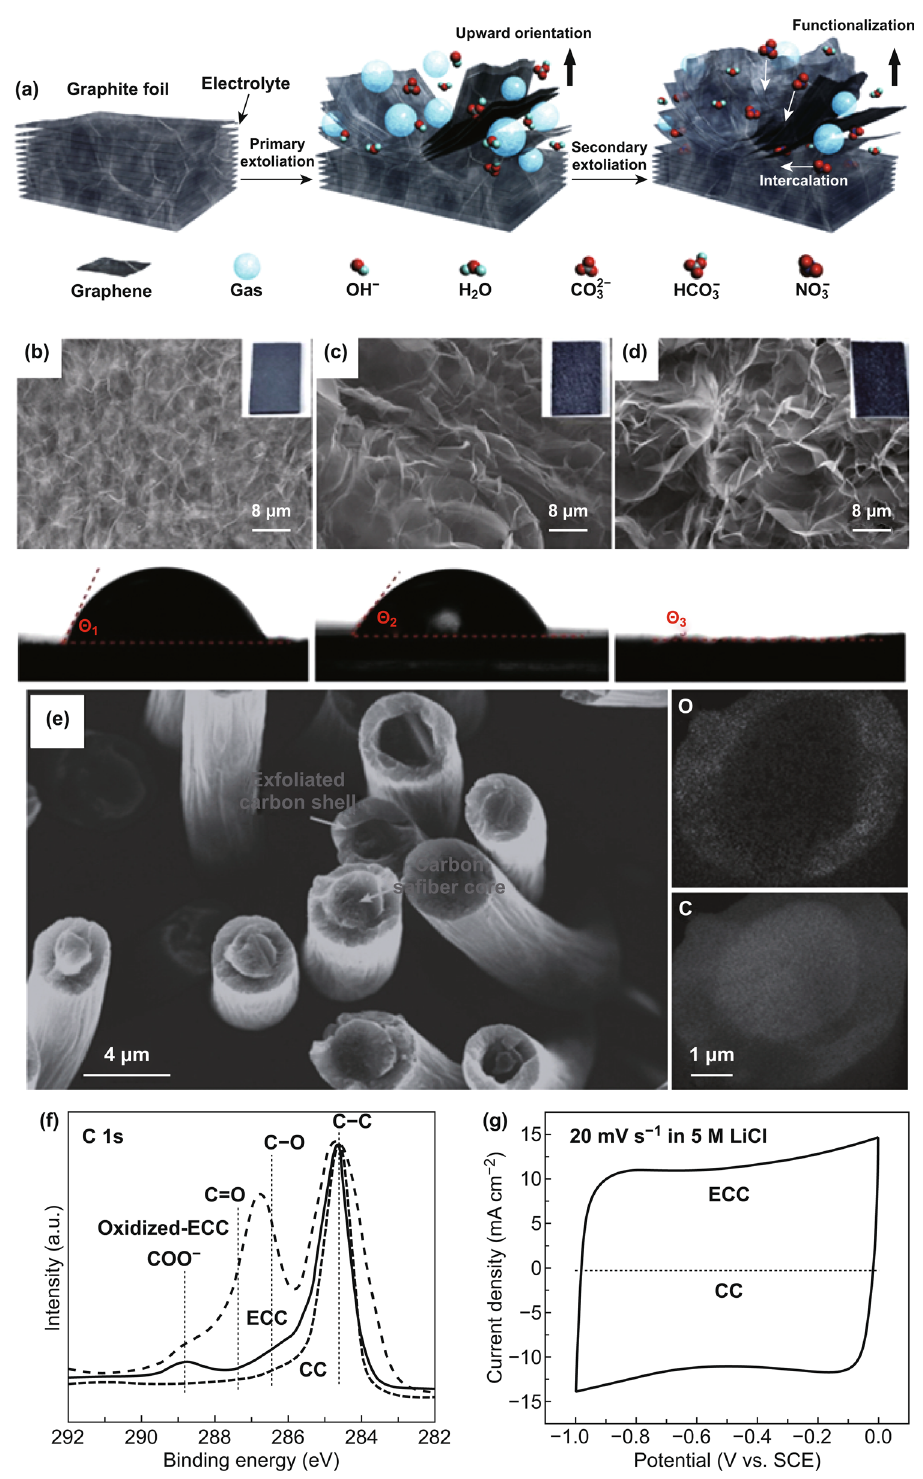
Fig. 9 a Schemes of the two‑step partial exfoliation of graphite foil. b – d SEM images and contact angles of b graphite foil, c graphite foil after primary exfoliation, and d graphite foil after secondary exfoliation. Insets: photographs of graphite foil at different treatment stages. e SEM image and EDS element mappings (C and O) of the cross sections of exfoliated carbon cloth fibers. f XPS C 1 s spectra of pristine carbon cloth (CC) and exfoliated carbon cloth (ECC). g CV curves of CC and ECC. Adapted from a – d Ref. [88] and e – g Ref. [37] with